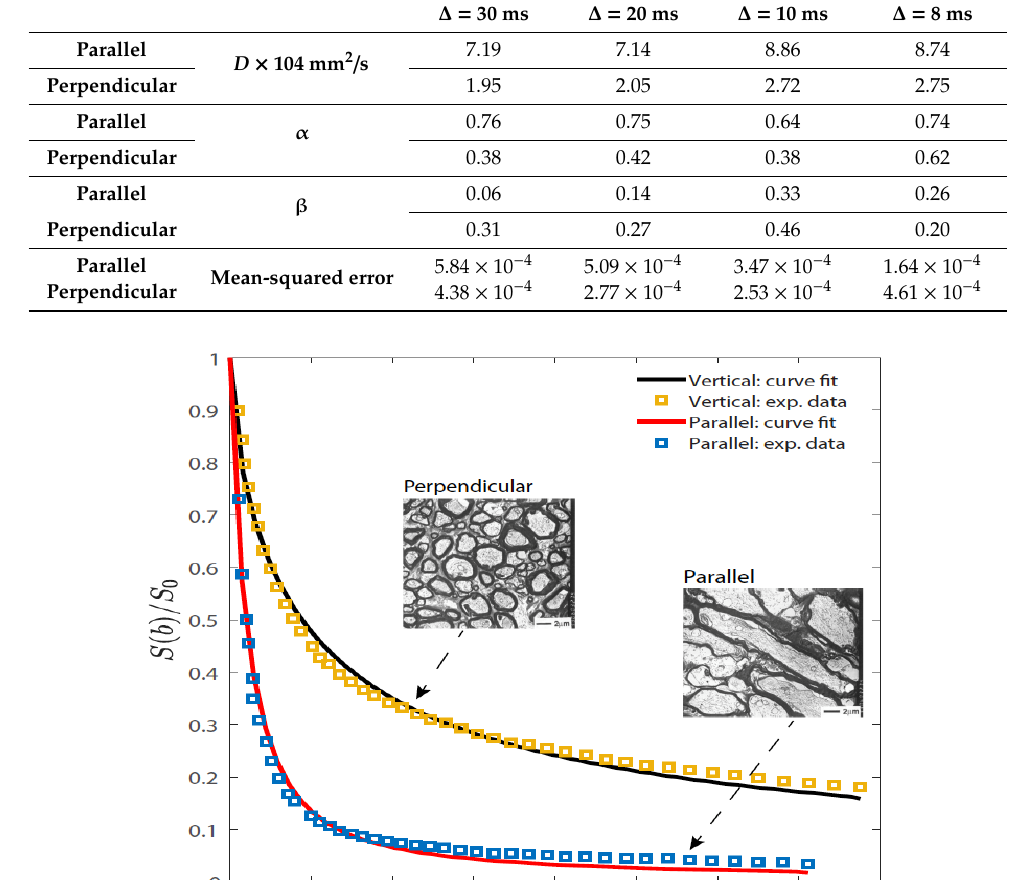
Table 2. Summary of Fitting Results for the Stretched Kilbas-Saigo Decay Model.